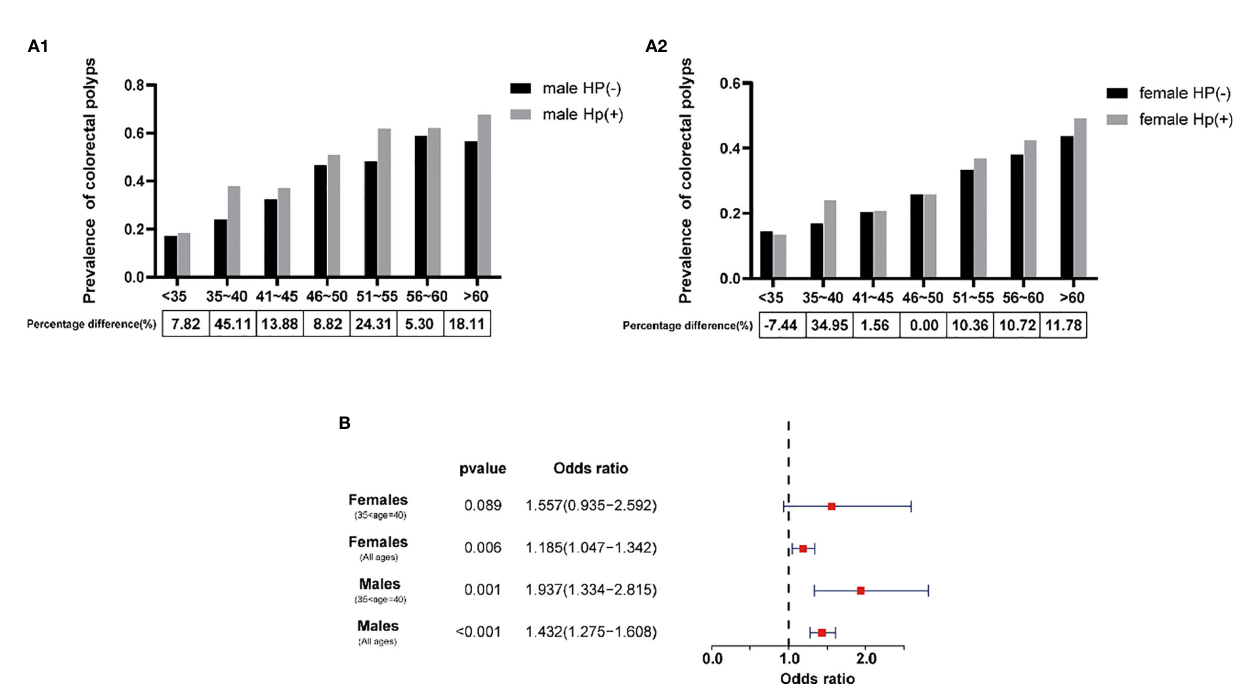
FIGURE 4 | The in fl uence of Hp on the prevalence of CPs in the Chinese of different ages. (A1) Relationship between the prevalence of CPs and Hp in males. (A2) Relationship between the prevalence of CPs and Hp in females. (B) OR value of Hp and different groups of age for CPs from logistic